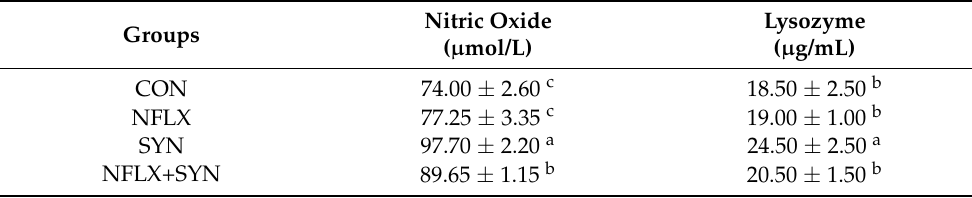
Table 3. Changes in the serum nitric oxide and lysozyme activities of Nile tilapia, O. niloticus , fed diets containing antibiotic (norfloxacin, NFLX) and synbiotic (SYN).